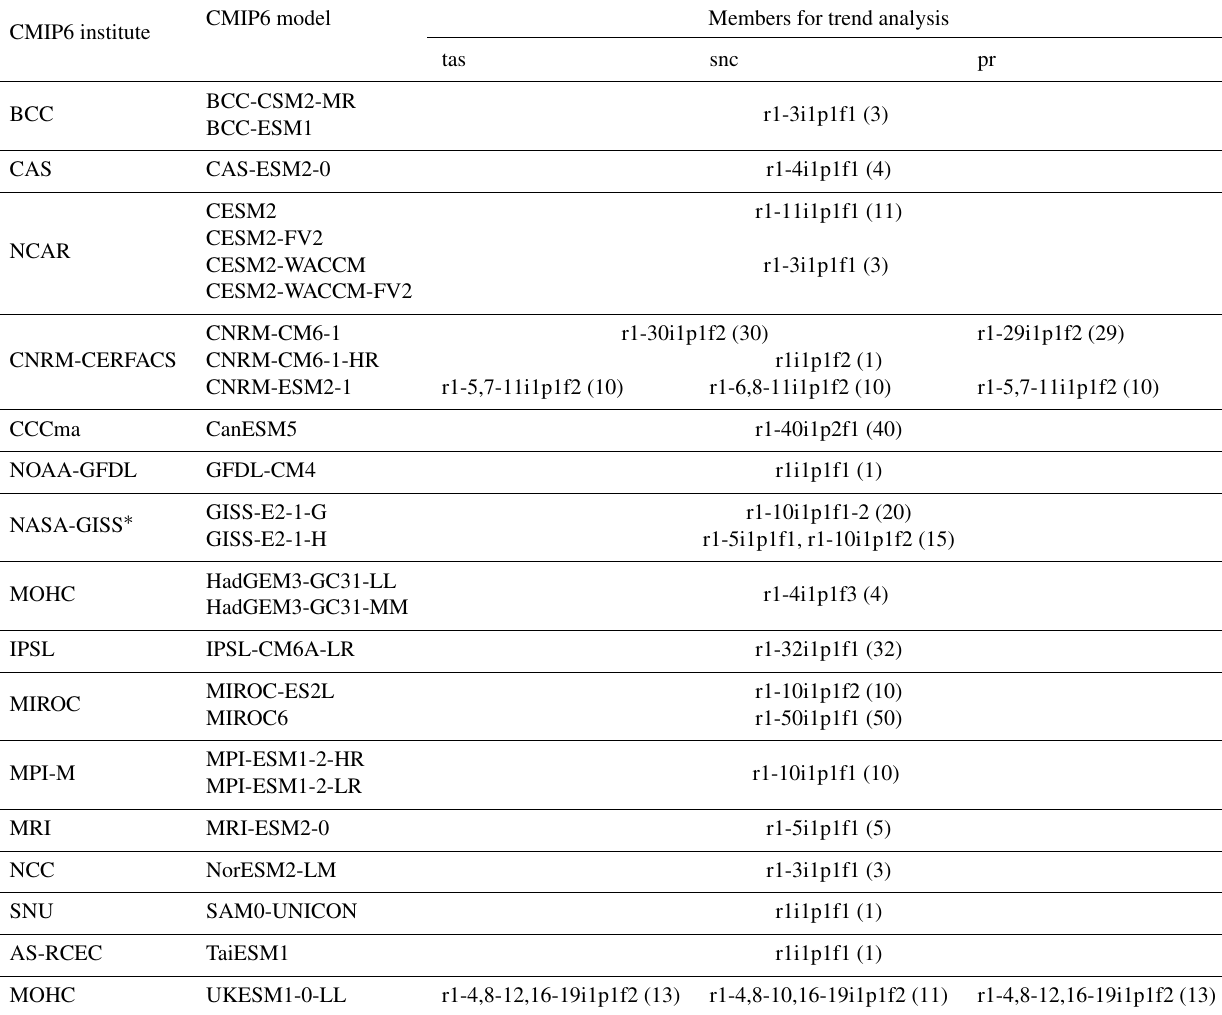
Table A1. Details of the members used from CMIP6 models for trends analyses for each